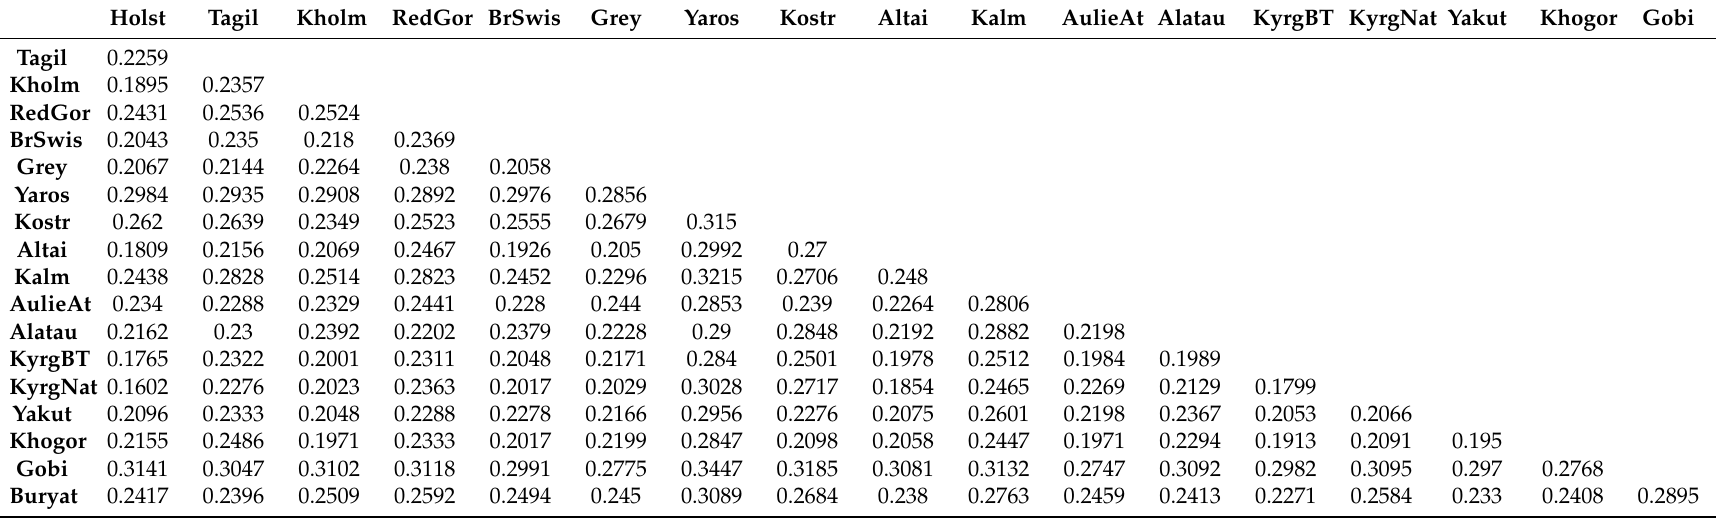
Table A6. Pairwise indices of allelic di ff erentiation among